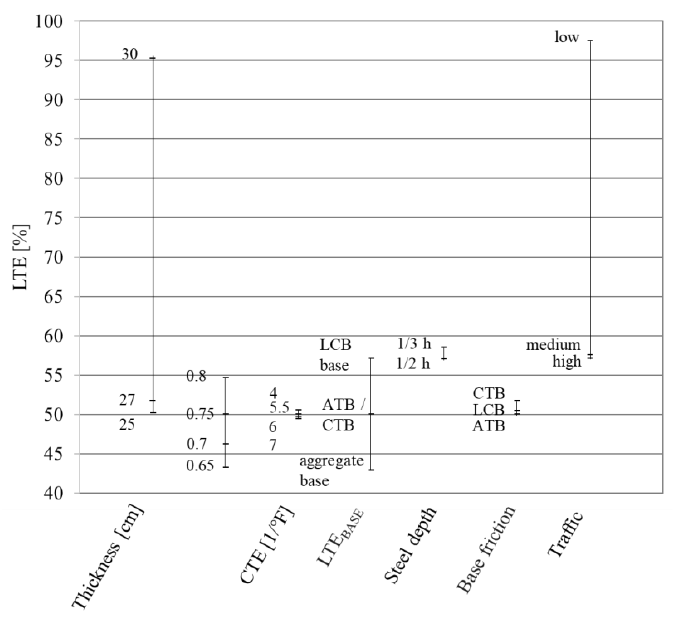
Figure 10. Relative impact of the individual variables on the LTE prediction by the MEPDG. Conversely, the LTE is only moderately sensitive to reinforcement ratio and base type, while it is insensitive to the coefficient of thermal expansion (CTE), steel depth, and base friction. The value of LTE depends on the type of base layer, reinforcement ratio, and crack stiffness. LTE is not a reliable indicator for predicting the punchout potential during regular construction regardless of a slab thickness and crack spacing higher than 90%, and with sufficient longitudinal reinforcement. Additionally, LTE values for a crack where a punchout process was performed remained at a relatively high level before and right after the development of the punchout [26]. The calculation for LTE adopted in the MEPDG is influenced by constant variables which are contributed by the base layer; the only parameter that changes over time and affects the LTE calculations is the variation in transverse crack stiffness (J c,i ). 4.5. Deflection An examination of the deflections was carried out using a falling weight deflectome- ter (FWD) in an interval of 20 m in the longitudinal direction [12]. The analysis of the FWD measurements on the Geseke private road in a timeframe of 10 years (Figure 11b) indi- cated that the FWD values on rolling lane 1 (N), between rolling lane l (N), and between rolling lane 2 (S) became larger. The bearing capacity was reduced, although, on the basis of the design procedures, a sufficient LTE is expected within the design life of 49 years (Figure 11a), and no punchout formation is expected within this period. The FWD was decreased only on rolling lane 2 (S), which can be justified by the influence of the traffic load in this area.